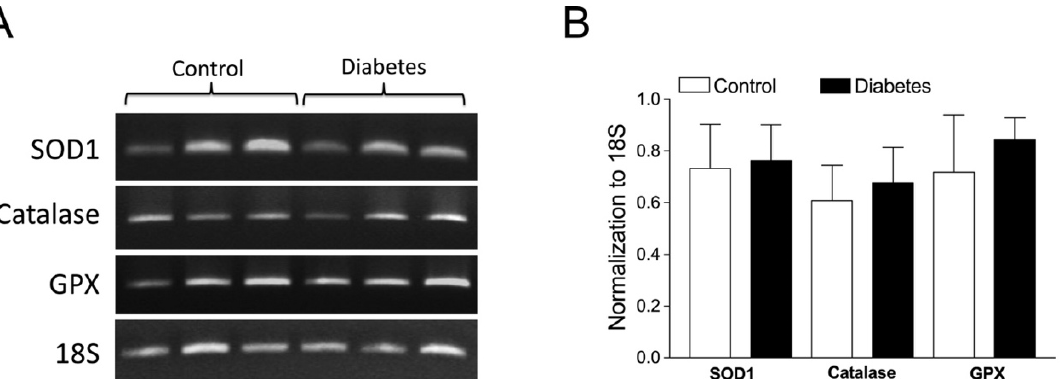
Figure 6. Effect of early diabetes on the mRNA expressions of SOD1, catalase, and GPX in isolated coronary arterioles. ( A ) The expressions of antioxidant genes (SOD1, catalase, and GPX) were determined by RT-PCR and the expressions were normalized to the 18S transcripts. ( B ) The quantitative analysis showed no difference in the antioxidant gene expressions between the control (n = 3) and diabetic (n = 3) coronary arterioles.